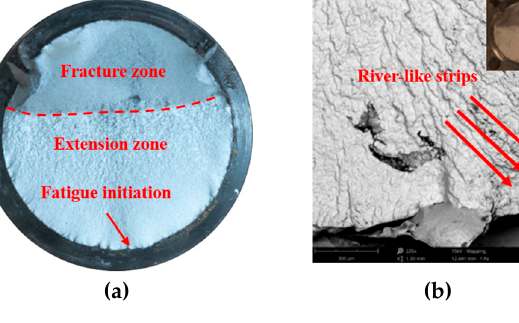
Figure 13. Fatigue macro-fractures of M20 torque-shear HSBs. ( a ) Macro-view fracture. ( b ) 300 times initiation zone. ( c ) 500 times extension zone. ( d ) 5000 times fracture zone.